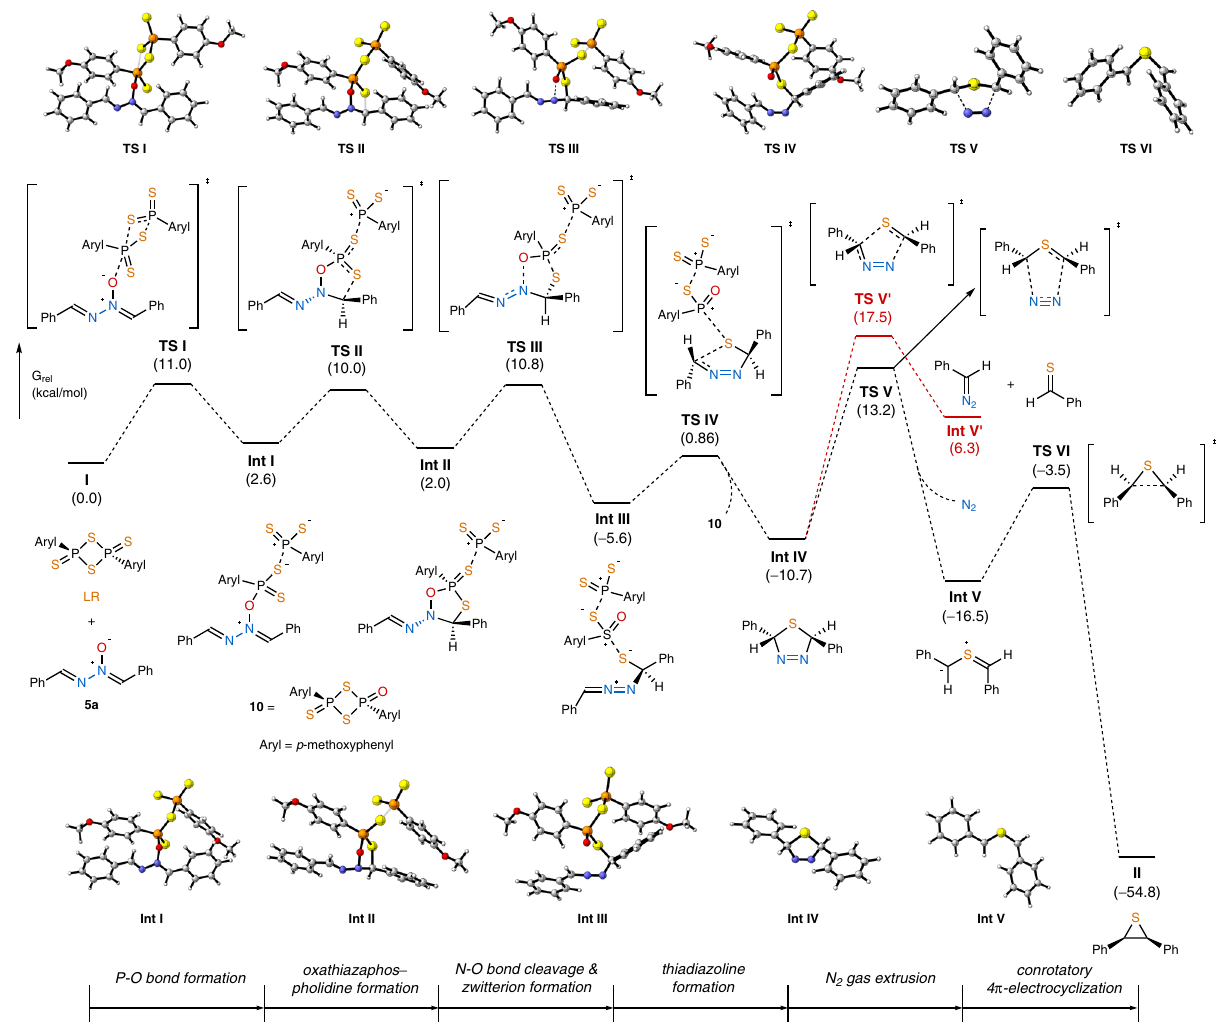
Fig. 6 | DFT calculation of the reaction mechanism via a thiocarbonyl ylide. Gibbs free energy pro fi le at the M06-2X/6-311+G(d,p)/PCM(DMF) level of